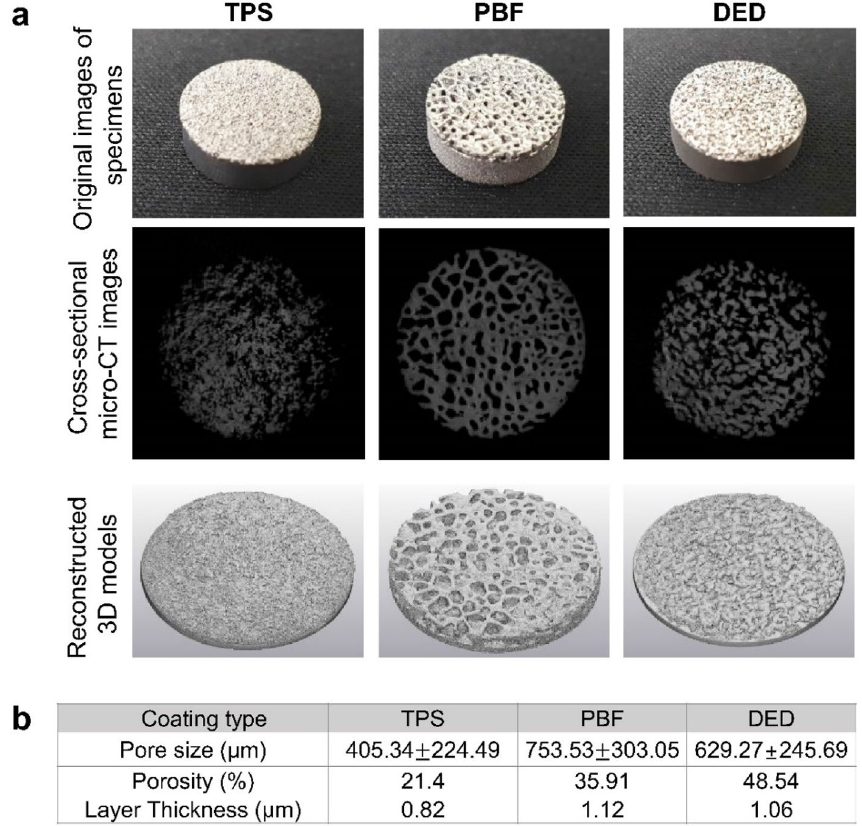
Figure 1. ( a ) Images of specimens (TPS, PBF, and DED): original images, cross-sectional images, and reconstructed 3D models. ( b ) Pore size, porosity, and thickness of coating layers.